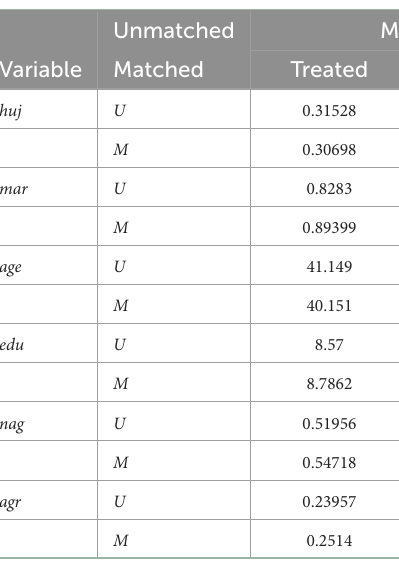
TABLE 8 PSM balance